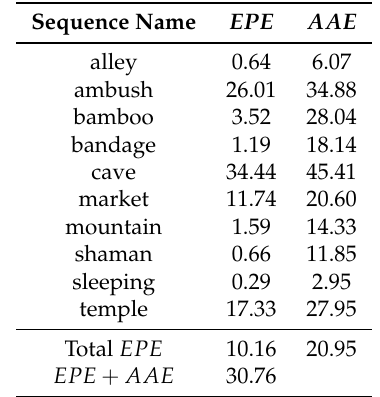
Table 18. Summary of results. The end point error and average angular error obtained by Horn-Schunck using uniform locations in the MPI-Sintel training